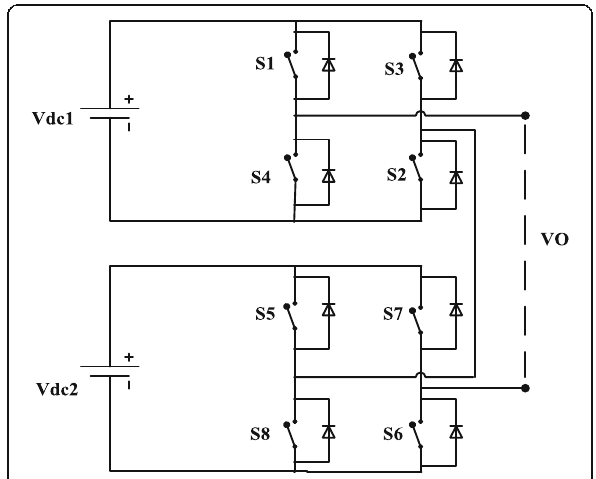
Fig. 1 Simulink model of five-level inverter